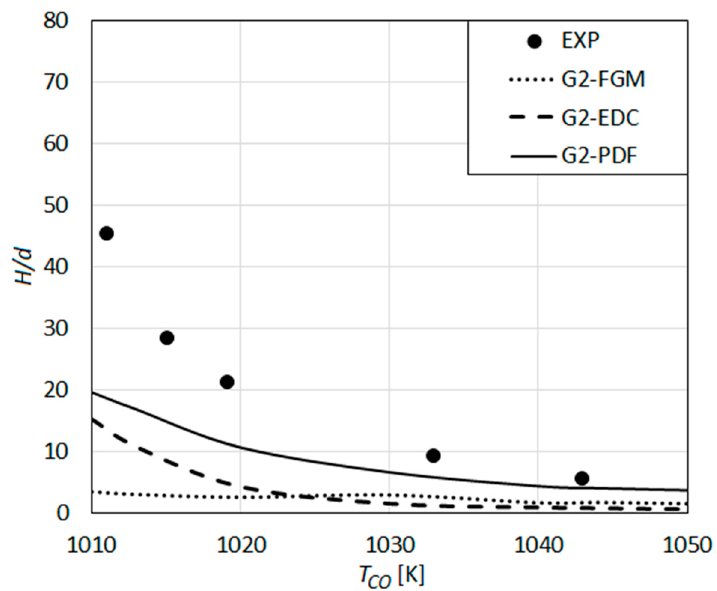
Figure 10. Lift-off height as a function of co-flow temperature: Predictions using the detailed reaction mechanism GRI-Mech 2.11 [27] compared with the measurements of Wu et al. [23].